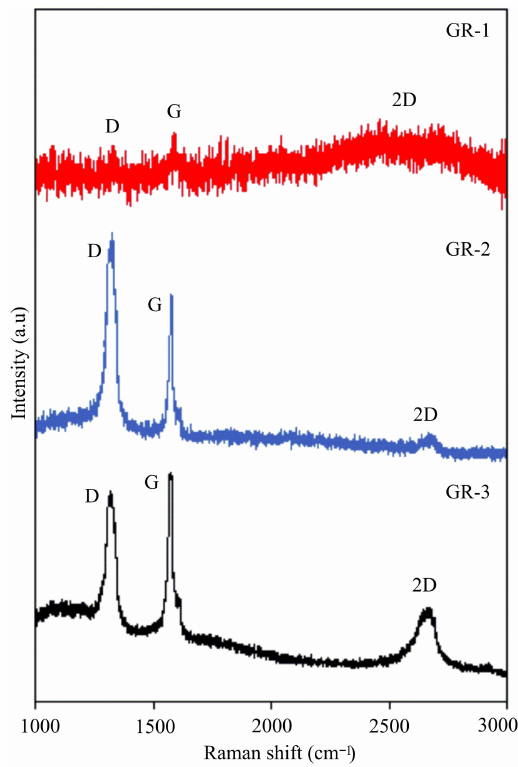
Figure 2. Raman spectra of three different graphite layers, where behavior of each assigned band indicates how composition of graphite was